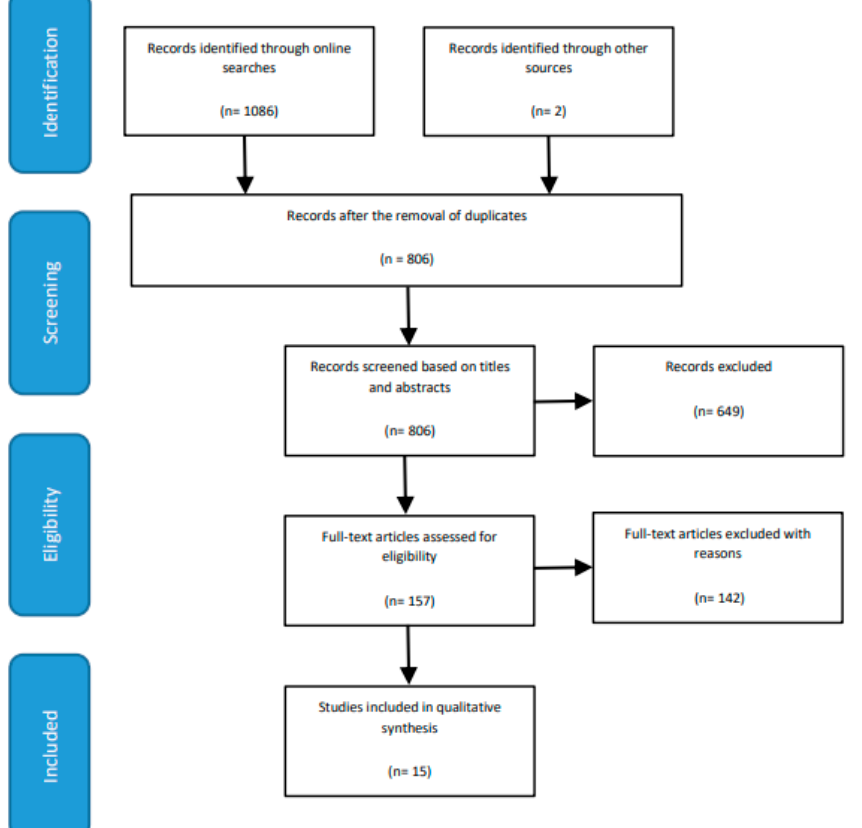
Figure 1. PRISMA Flow Diagram illustrating the steps taken in conducting the systematic review.